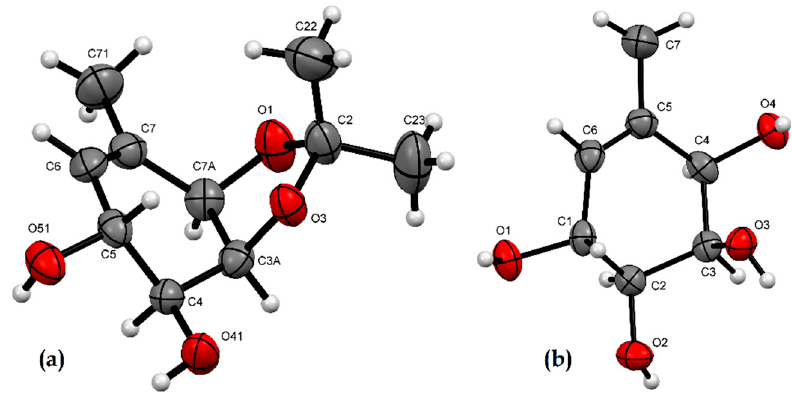
Figure 1. Oak Ridge Thermal Ellipsoid Plot ( ORTEP) plots of the crystal structures of ( a ) methyl-conduritol C acetonide ( 5 ) [12], and ( b ) ( − )-methyl-conduritol C ( 6 ).